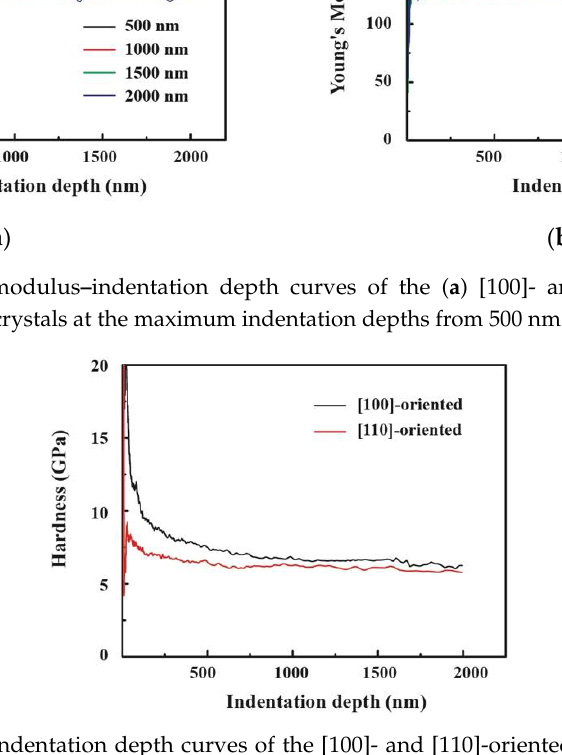
Figure 6. Young’s modulus – indentation depth curves of the ( a ) [100]- and ( b ) [110]-oriented